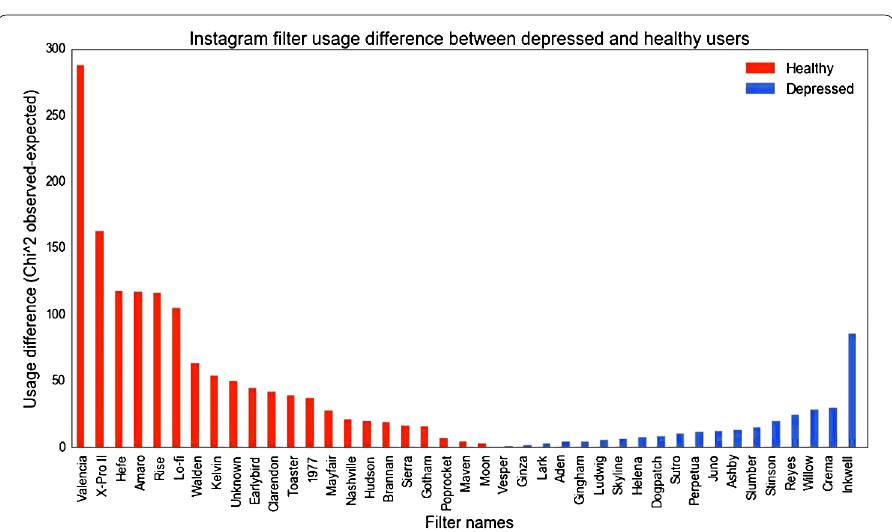
Figure 3 Instagram filter usage among depressed and healthy participants . Bars indicate difference between observed and expected usage frequencies, based on a Chi-squared analysis of independence. Blue bars indicate disproportionate use of a filter by depressed compared to healthy participants, orange bars indicate the reverse. All-data results are displayed, see Additional file 1 for Pre-diagnosis plot.